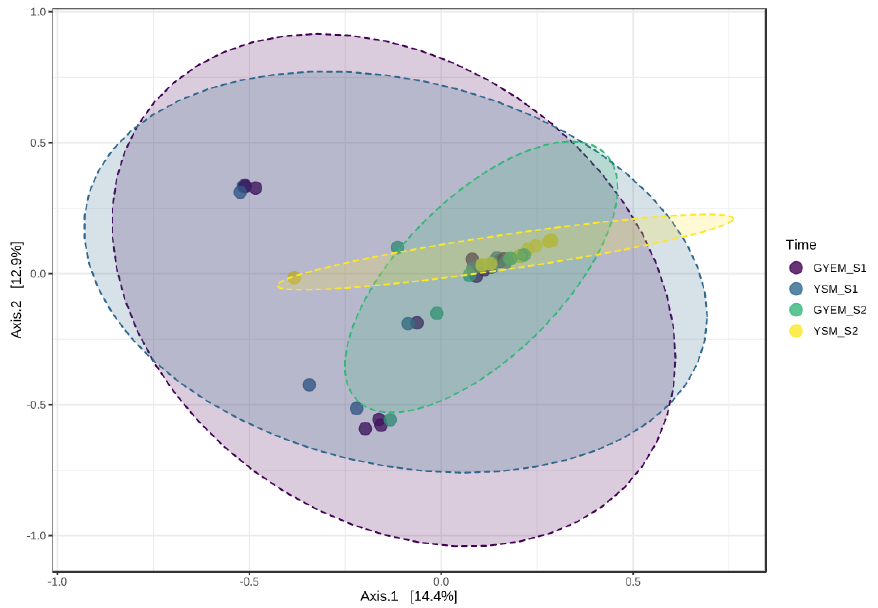
Figure 3. Bray − Curtis measures of beta-diversity visualised using principal coordinate analysis (PCoA) for the comparison of fungal diversity for enrichment (S1 and S2) of tailing samples using GYEM and YSM.